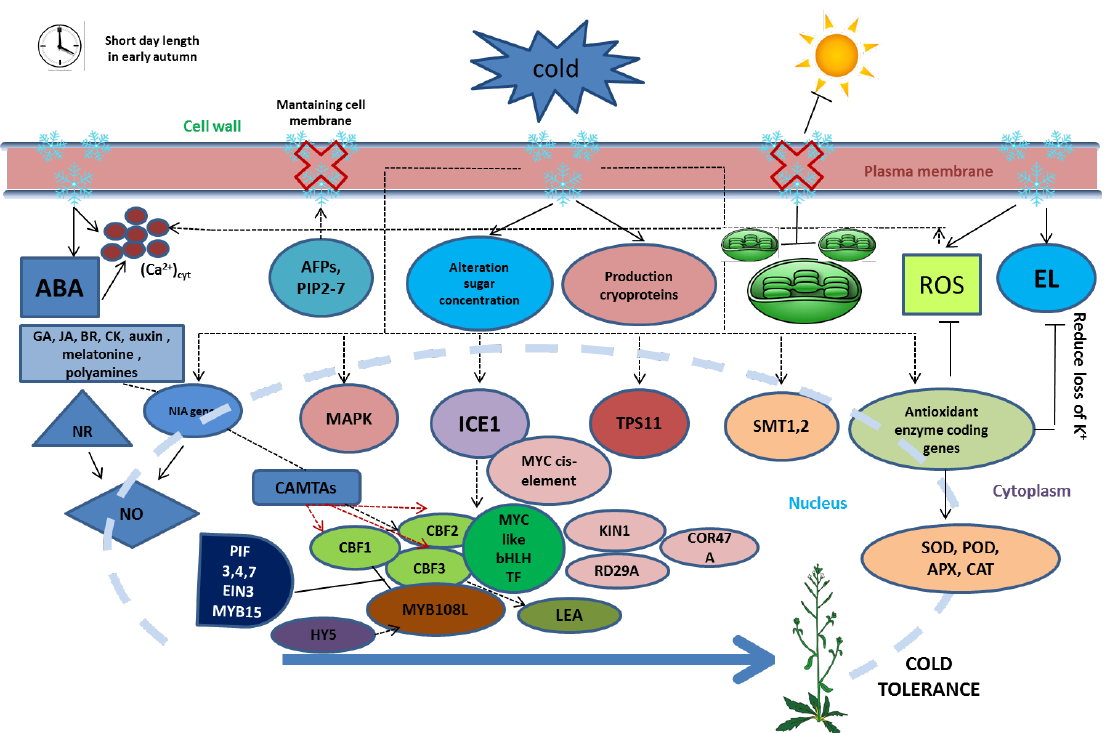
Figure 2. The mechanism of cold tolerance in plants. A short day in early autumn represents the first initiation of cold stress. AFPs and PIP2-7 slow ice crystal formation to maintain cell membranes and reduce membrane injury. However, low temperature (LT) still causes some changes in membrane structure, sugar concentration, and production in cry proteins. LT initiates the increase of ABA, EL, (Ca 2+ ) cyt , and ROS accumulation but decreases chloroplast number. LT induces the expression of some genes, such as NIA , MAPK , TPS11 , SMT1 ,2, ICE1 and antioxidant enzyme coding genes. Antioxidant enzyme coding genes reduce the EL and increase the activity of the antioxidant enzymes in cold stress plants. Meanwhile, NIA genes and NR initiate NO as a result of LT. ICE1 , CAMTAs, NIA , and hormones induce the expression of CBFs , which bind to CRT/DRE cis-elements to enhance cold tolerance. ICE1-CBFs induce expression of cold-responsive genes, such as KIN1 , RD29A , COR47A , and LEA , during cold stress.